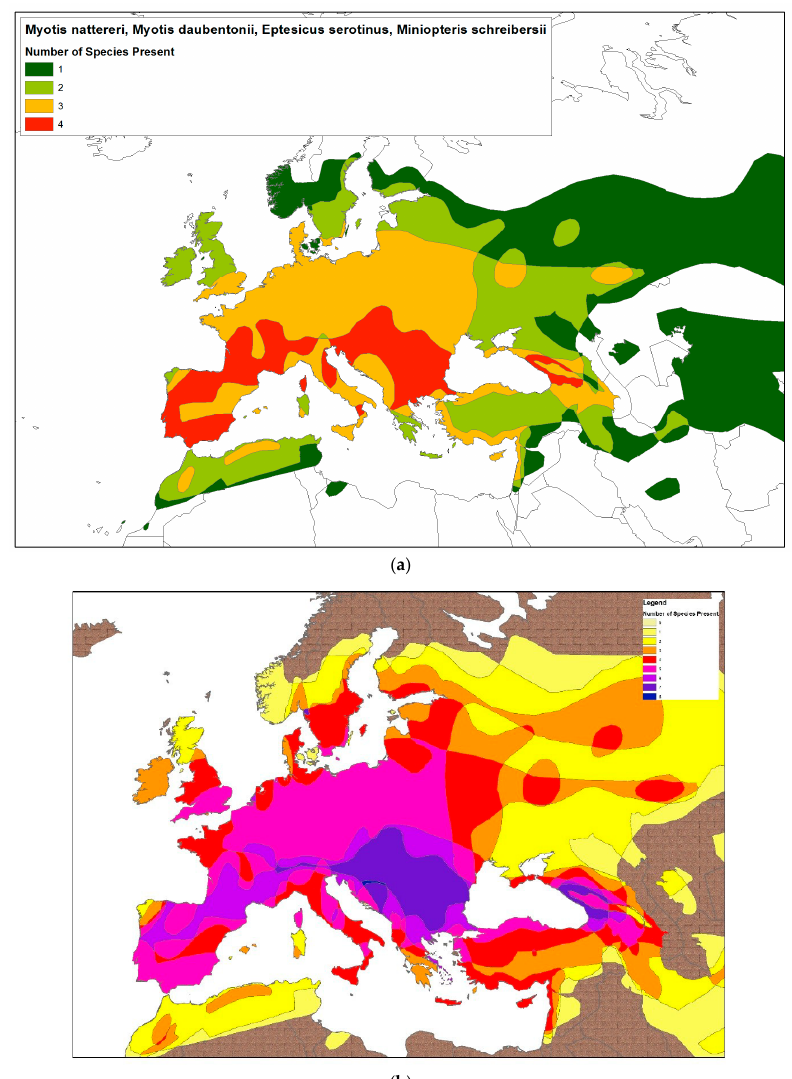
Figure 2. (a) Risk map for bat species most commonly reported as infected with lyssaviruses in the EU. Data includes ranges of Eptesicus serotinus (EBLV-1), Myotis daubentonii (EBLV-2), Myotis nattereri (BBLV), and Miniopteris schreibersii (LLEBV and WCBV). Data derived from IUCN (https://www.iucn.org/). (b) Risk map for all bat species associated with lyssavirus infection across Europe. Data includes ranges of Eptesicus serotinus (EBLV-1), Myotis daubentonii (EBLV-2), Myotis nattereri (BBLV) and Miniopteris schreibersii (LLEBV and WCBV), Myotis mystacinus (KHUV) , Myotis brandtii (KBLV) , Myotis blythii (ARAV) , and Murina leukogaster (IRKV).